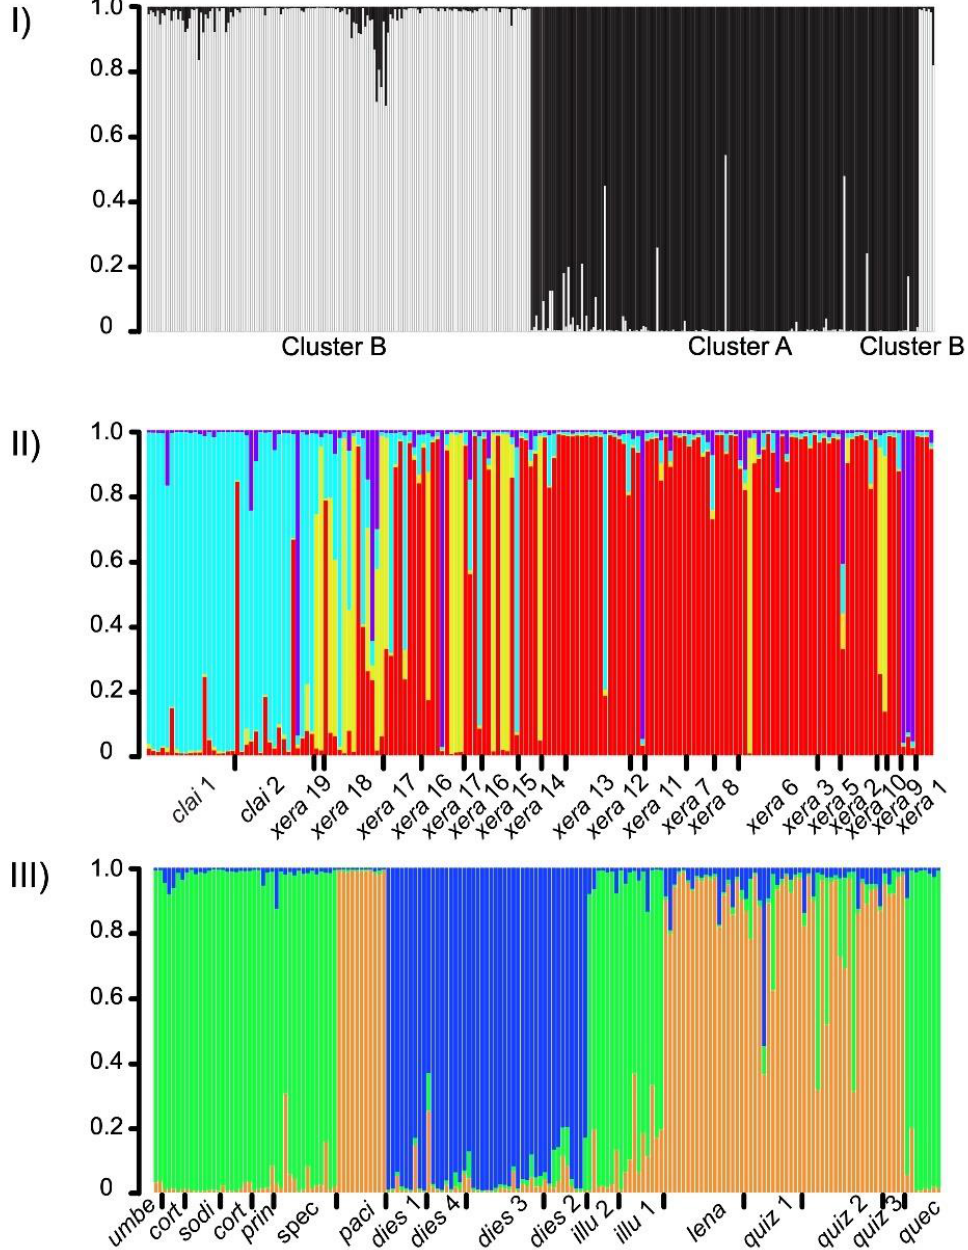
Figure 1. Bar plots showing the average cluster assignment probability in nested STRUCTURE analyses of the AFLP data for individuals from different species of Macrocarpaea . Each bar represents one individual, and the color indicates the source of the genetic cluster of its genotype. Bars are sorted according to decreasing latitude (north–south gradient). ( I ) Analyses including all the individuals sampled in the study. ( II ) Analyses performed on the individuals assigned to cluster A, representing M. claireae and M. xerantifulva . ( III ) Analyses performed on the individual assigned to cluster B, representing all the ten remaining species. The abbreviations of the names of the populations (see Table 1) are indicated below the bars and are formed by the first 4 characters of the species name.